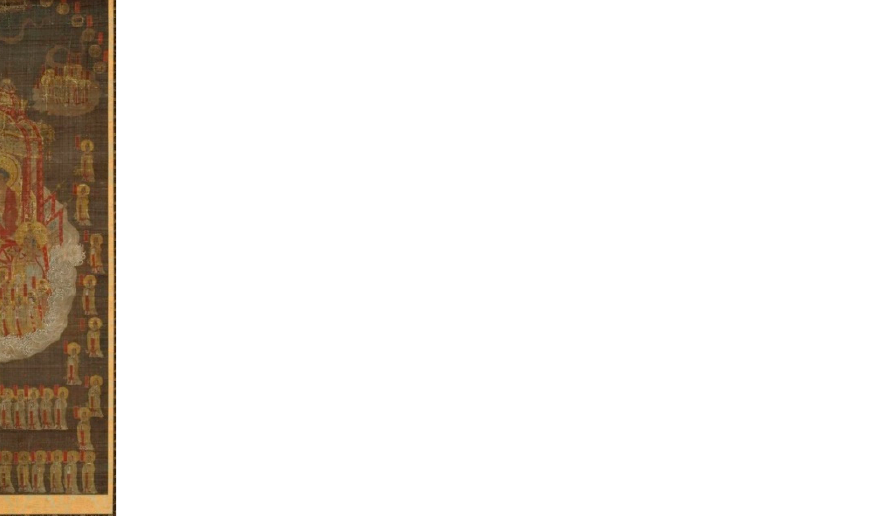
Figure 5. Chixingguang rulai wanglintu 熾星光如來往臨圖 (The Descent of Tejaprabh ā Buddha), MFA, Boston, Ink, colors, and gold on silk, 124.4 cm × 54.8 cm, Late 14th century (Korean Goryeo Dynasty). The print shows the Nine Luminaries in the anthropomorphic form: at the viewer’s right of the Buddha, the Sun Bodhisattva, Mercury, and Jupiter; at the viewer’s left, the Moon Bodhisattva, Venus, and Mars. In the center, in front of the Buddha’s throne, is Saturn on the viewer’s right and a crowned female opposite, possibly Dimu, the Earth